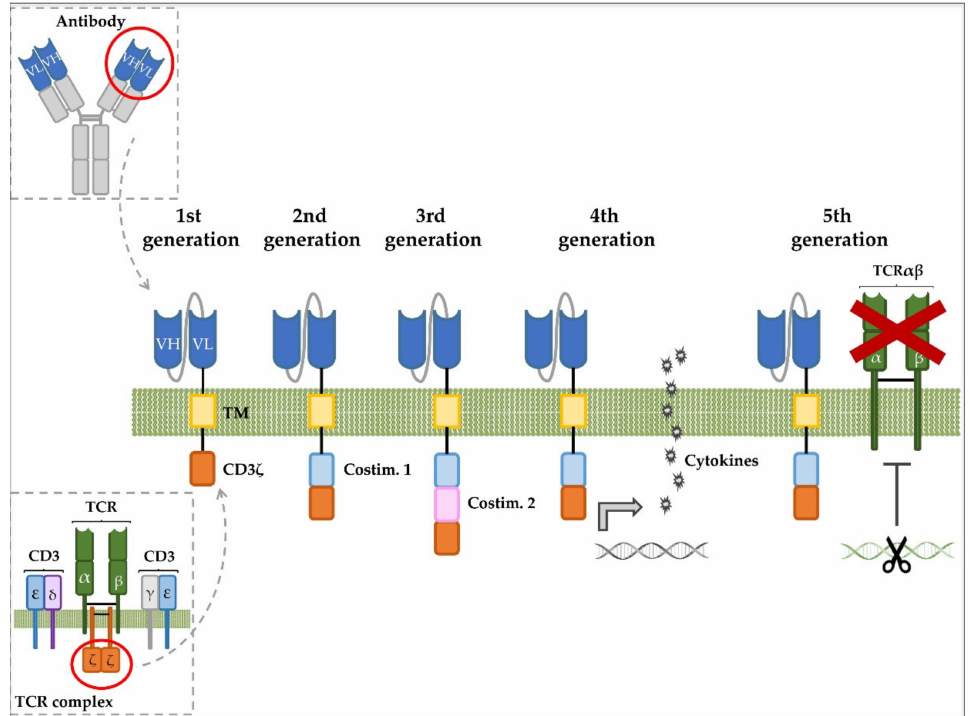
Figure 3. Schematic representation of the di ff erent CAR generations. CARs are